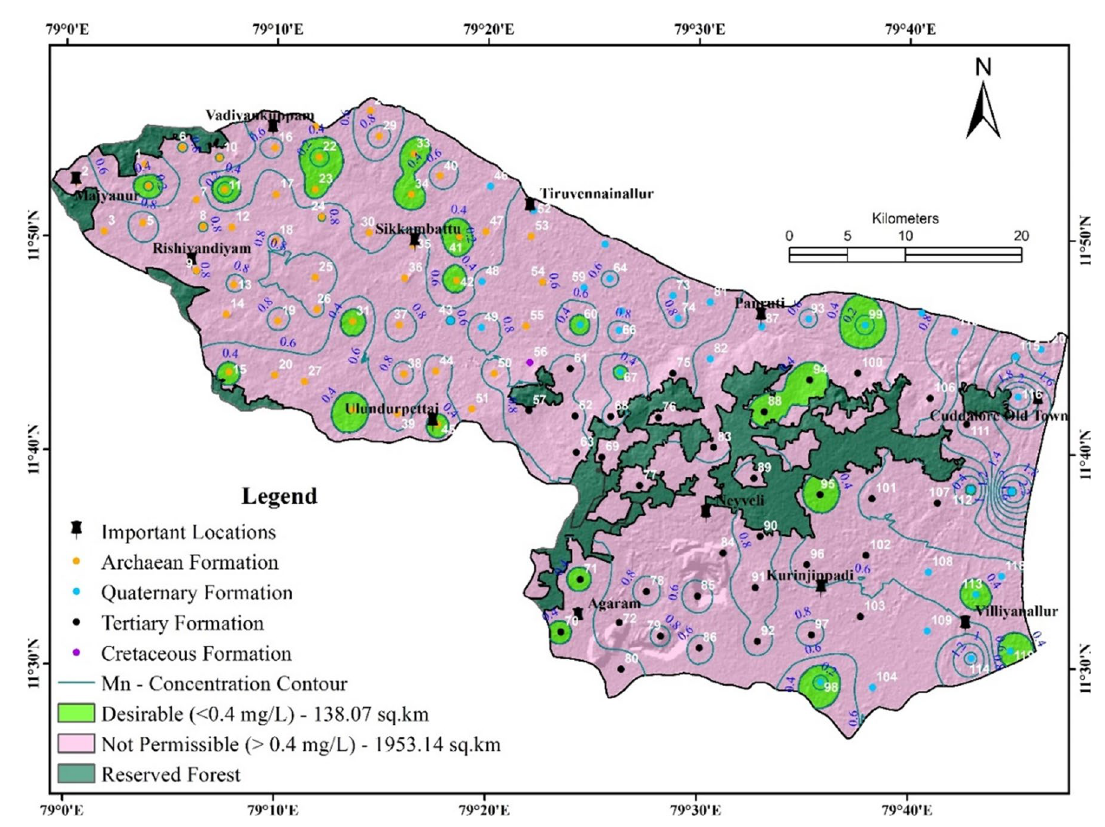
Fig. 12 Spatial variation with contour map of manganese in